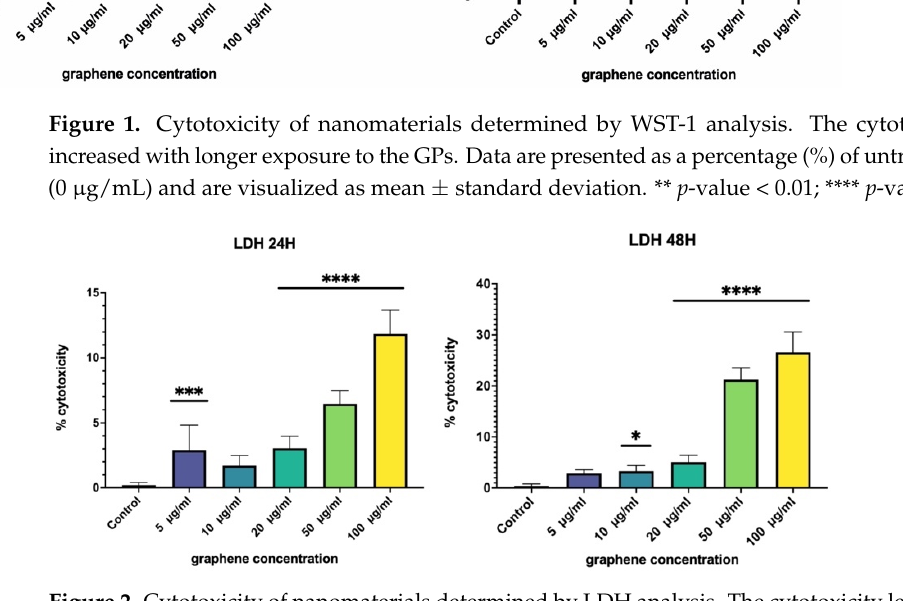
Figure 1. Cytotoxicity of nanomaterials determined by WST-1 analysis. The cytotoxicity level in- creased with longer exposure to the GPs. Data are presented as a percentage (%) of untreated control (0 μ g/mL) and are visualized as mean ± standard deviation. ** p -value < 0.01; **** p -value < 0.0001.